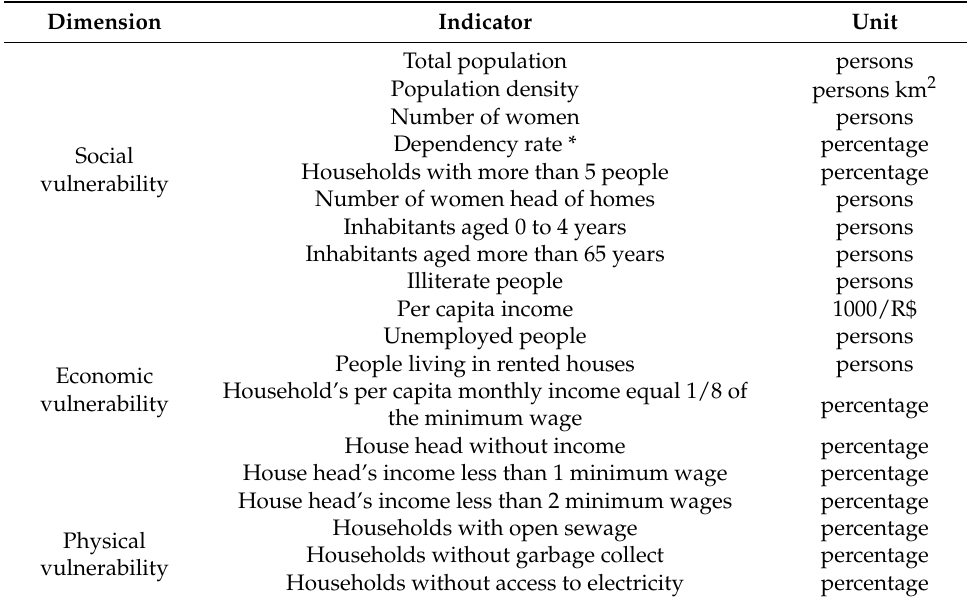
Table 1. Input flood vulnerability indicators, their dimensions, and units.